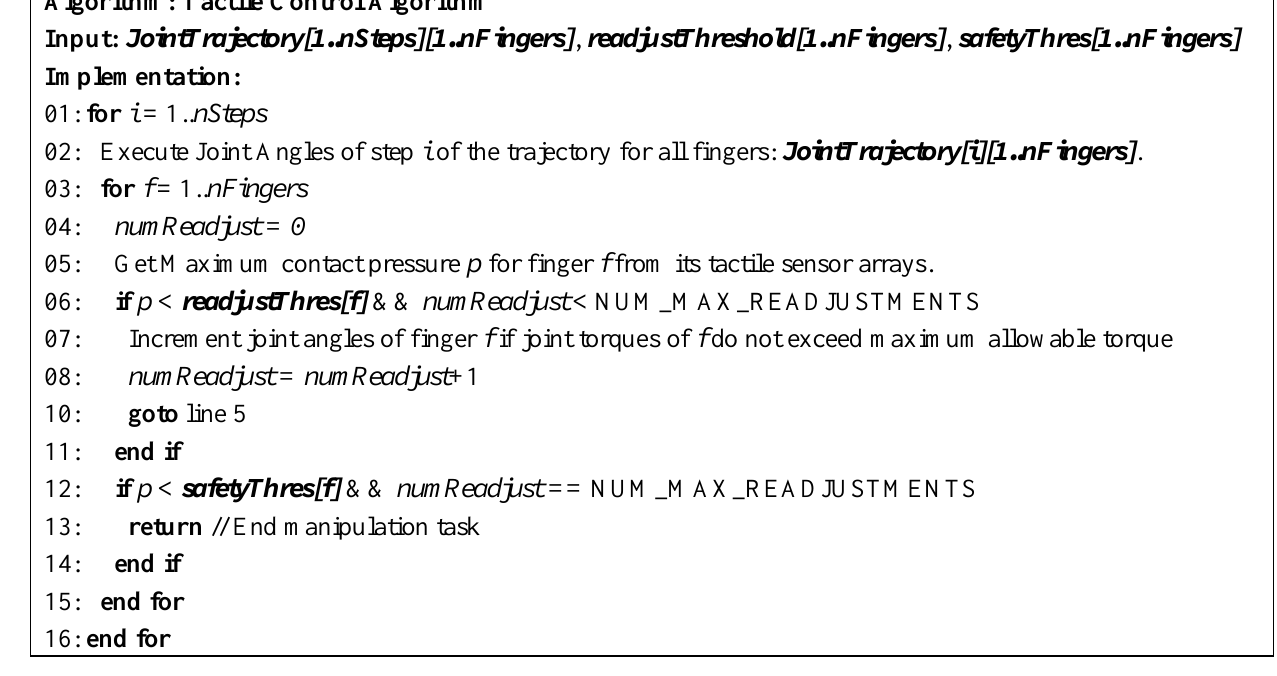
Algorithm 1. Tactile Control Algorithm. Algorithm: Tactile Control